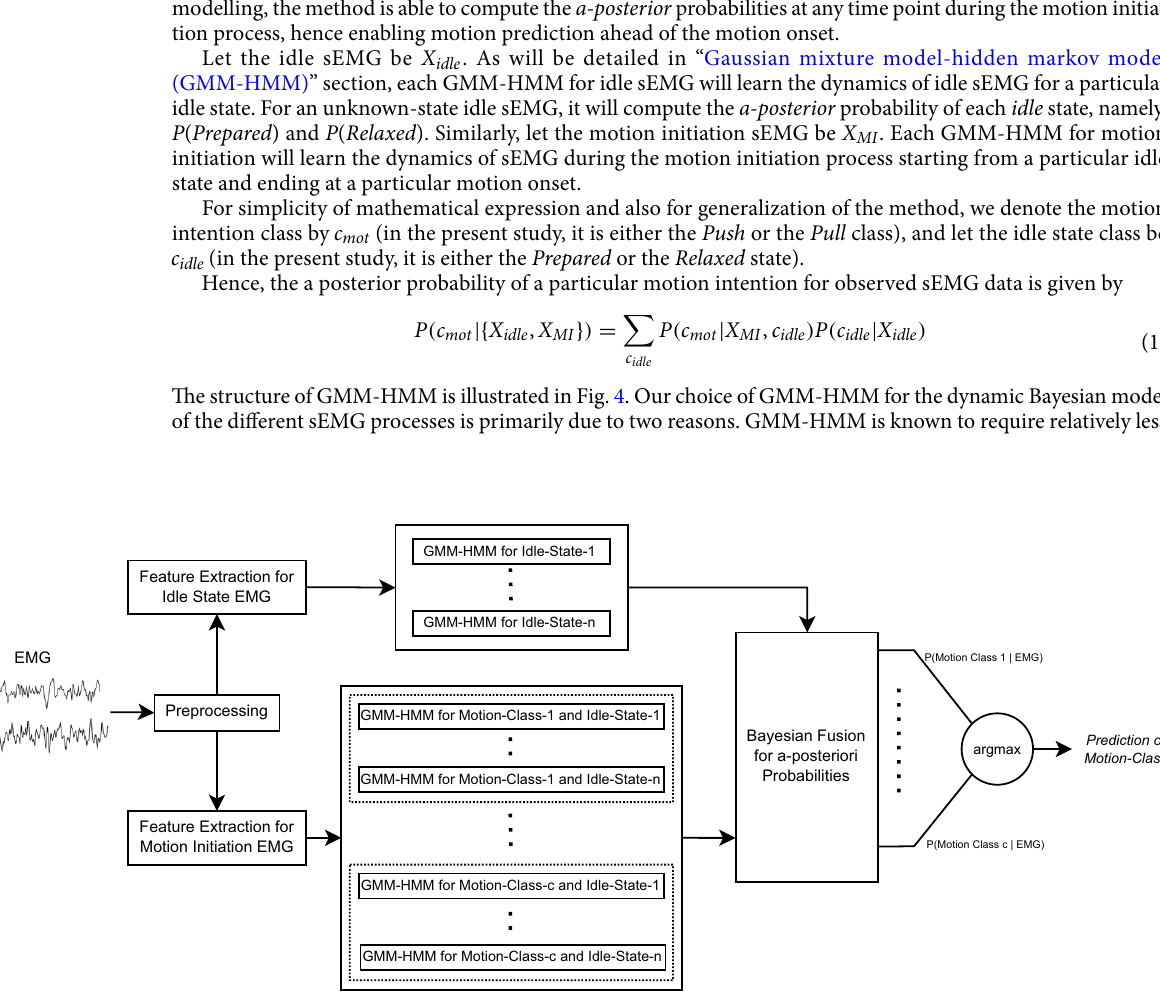
Figure 3. Diagram of the Hybrid Bayesian Dynamic Model for sEMG-based Motion Intention